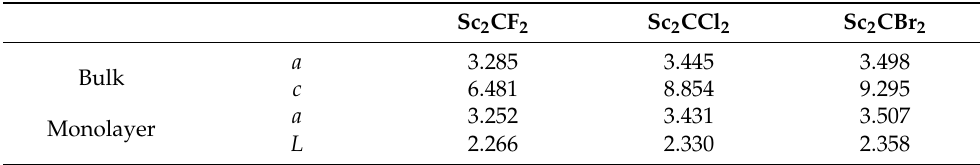
Figure 1. ( a ) Crystal structure of bulk Sc 2 CT 2 (T = F, Cl, Br). ( b ) Side view and ( c ) top view of single-layer Sc 2 CT 2 . Table 1. The calculated lattice parameters a (Å) and c (Å) of bulk Sc 2 CT 2 , the lattice parameters a (Å) and Sc–C bond lengths L (Å) of monolayer Sc 2 CT 2 .